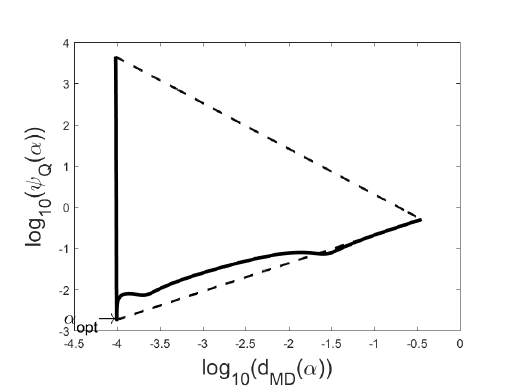
Figure 7. Q-curve in Foxgood.